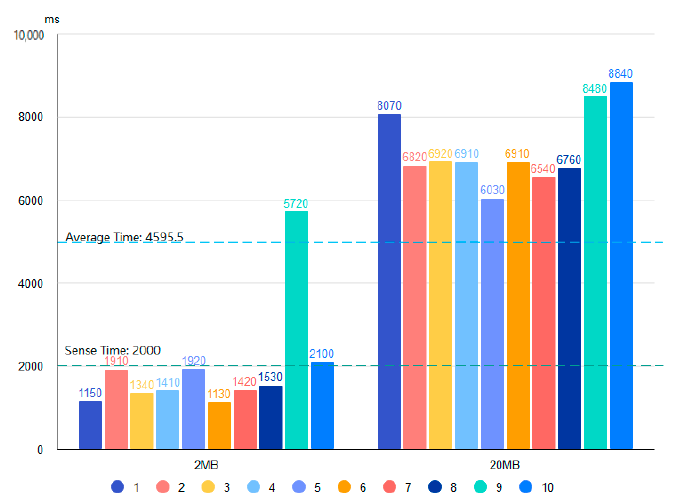
Figure 11. Time test of Pattern II.